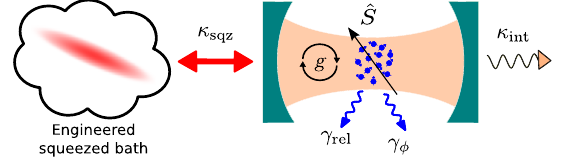
FIG. 1. Schematic representation of a generic approach to generate dissipative spin squeezing by coupling spins to a bosonic mode that interacts with a squeezed reservoir. The squeezing rate experienced by the cavity is governed by the parameter κ , while g represents the spin-cavity coupling sqz strength. Limiting factors to the protocol ’ s performance are the intrinsic photon-loss rate κ , the local spin-relaxation rate γ , int rel and the local spin-dephasing rate γ ϕ